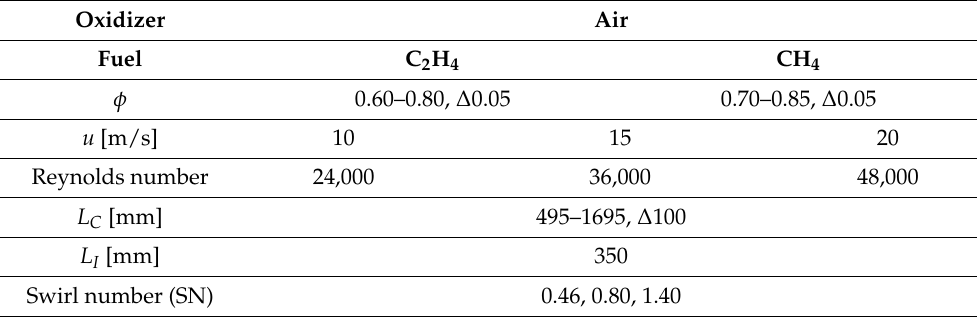
Table 1. Experimental conditions.